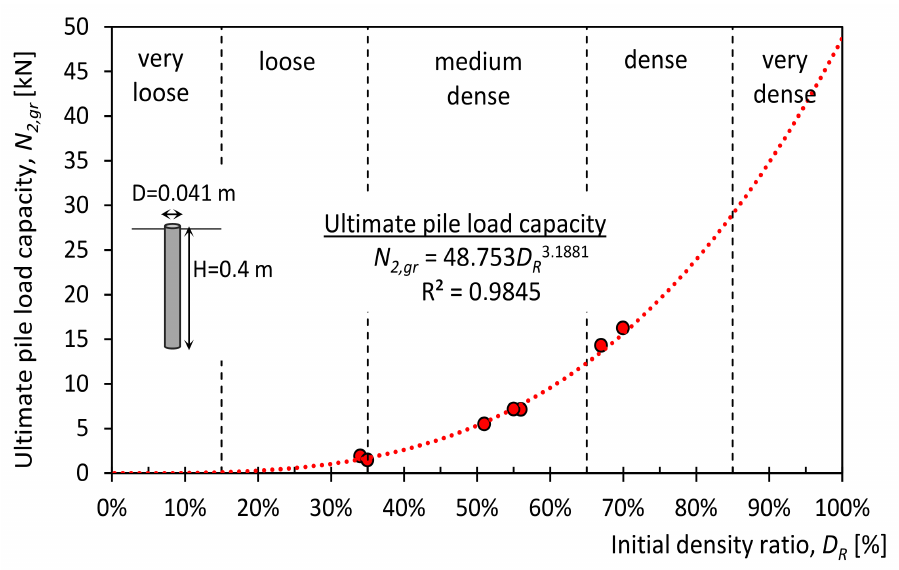
Figure 17. Pile load capacity versus density ratio of soil (experimental values—red dots, approxima- tion model—red dashed